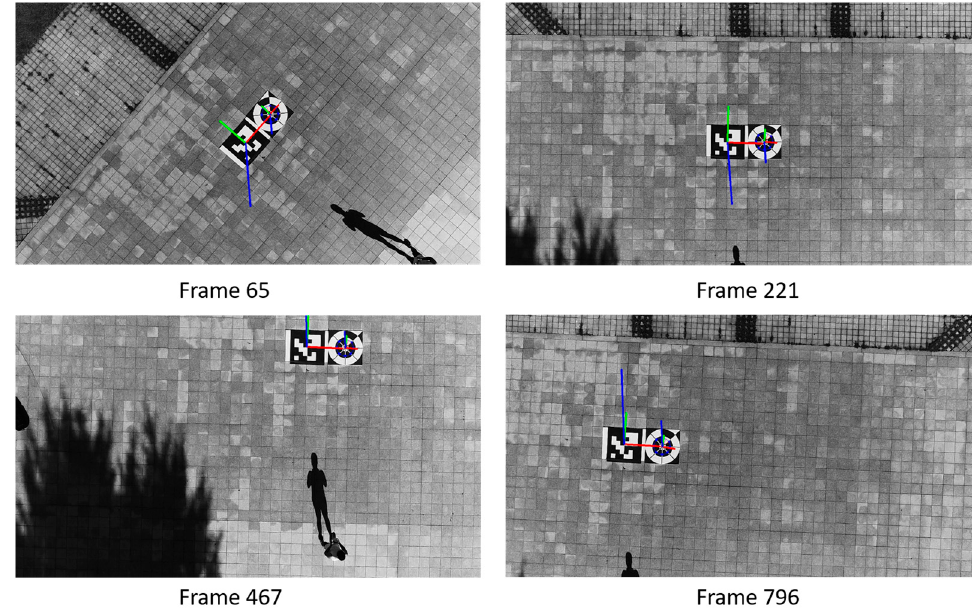
Figure 18. Examples of computed pose estimation of our proposed marker compared to ArUco marker in the case of free style flying.